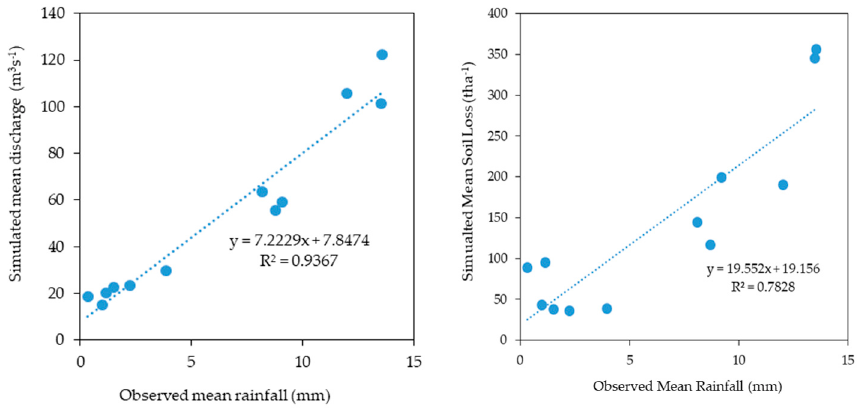
Figure 10. A bivariate scatterplot demonstrates the linear correlation between observed and simulated parameters for 2017–2021.